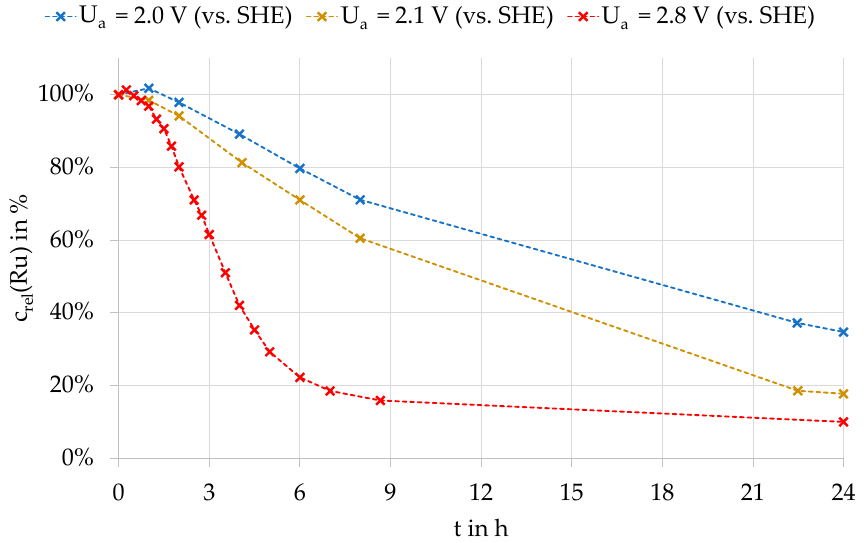
Figure 5. Progress of relative ruthenium concentrations (c rel (Ru)) at different anode potentials (U a ) during electrolysis at 240 A/m² and 60 °C. The reaction rate was calculated using the linear section of the concentration-time curves. As Figure 6 shows, there is a linear relationship between the anode potential and the oxidation rate of ruthenium for all three temperatures. Again, the strong influence of temperature on the oxidation rate can be clearly seen. The straight line at 40 °C also shows the results of the experiments with current densities of 100 and 500 A/m². These also fit onto the straight line. Consequently, the current density has no significant influence on the oxidation rate.